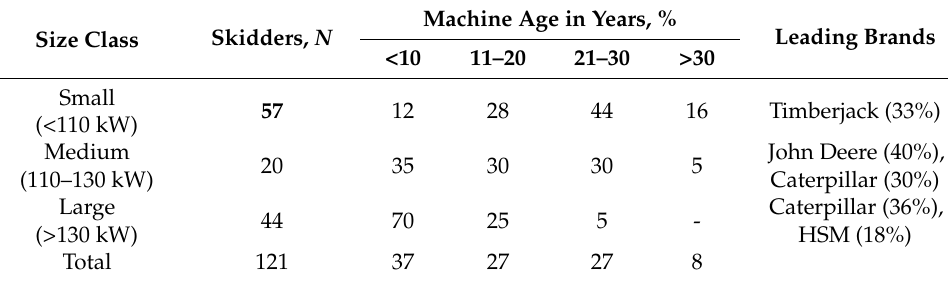
Table 2. Size, age and brand of the investigated